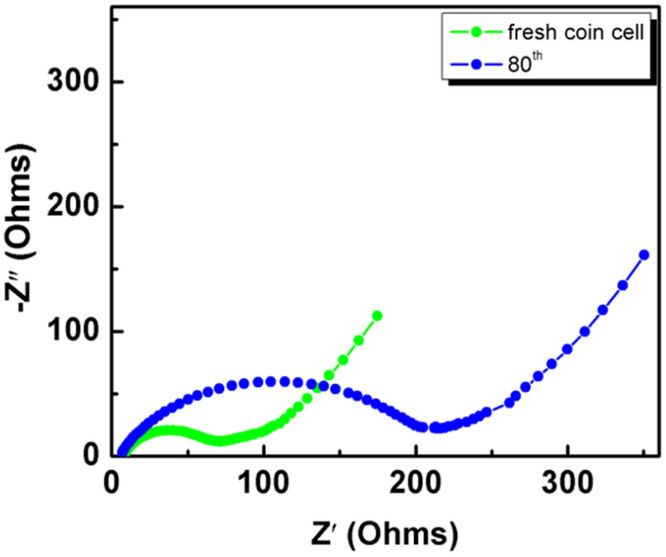
Nyquist plots of the MoS2-CNFs free-standing electrode.